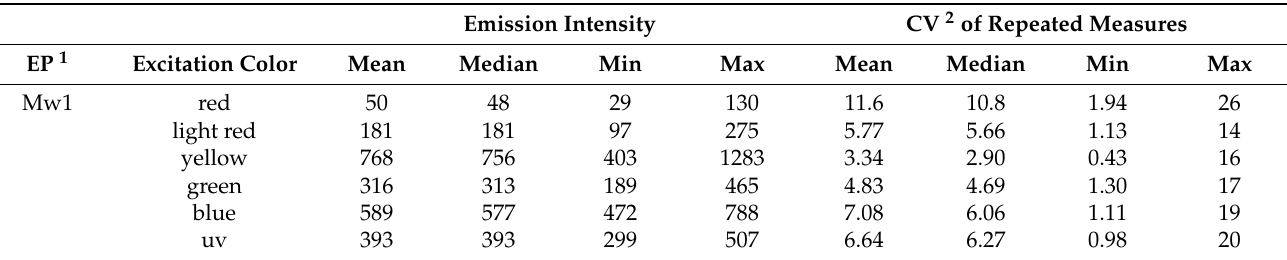
Table 2. Mean emission (counts/0.1 s) of all n = 152 samples, given for selected EPs, and the mean, median, and maximal variation (min., max.) of the CV (%) of the repeated measurements per sample. Emission Intensity CV 2 of Repeated